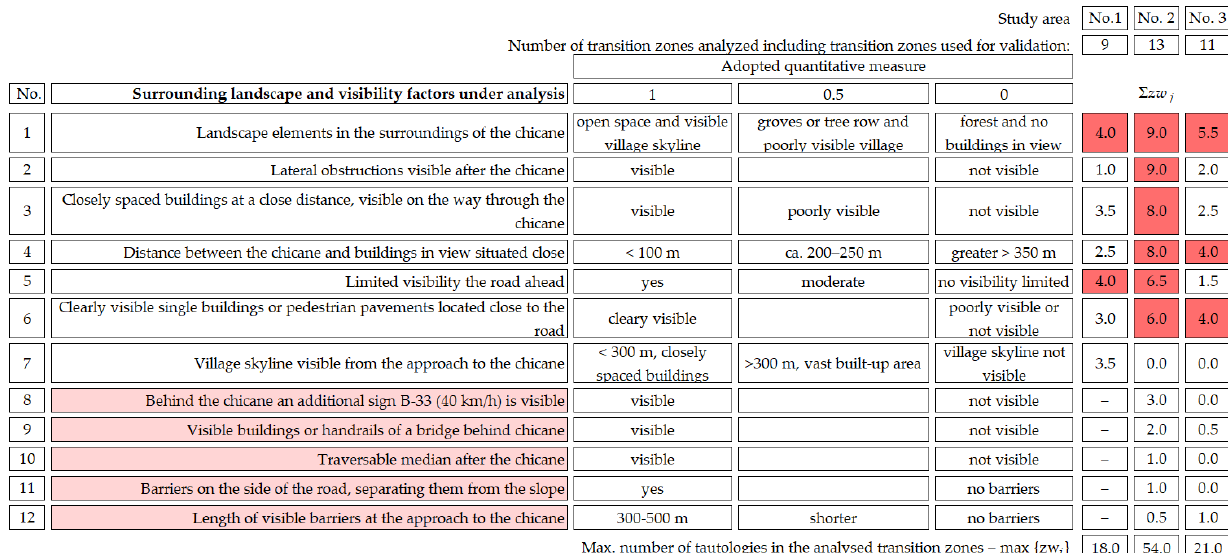
Figure 17. Comparison of initially adopted SLV factors in the analysed study areas based on the studies in [26,27]. Legend: zw j —number of confirmed tautologies on all the analysed transition zones in a given study area; (–) excluded from consideration in a given study area.